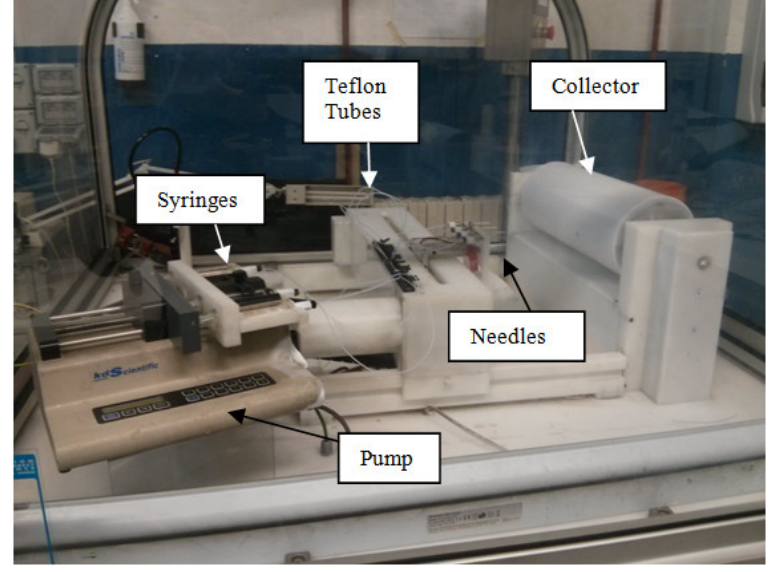
Figure 2. Electrospinning machine [21].